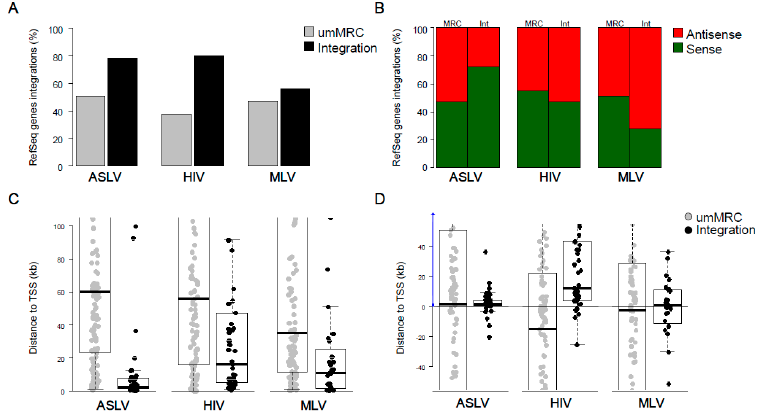
Figure 3. Analysis of genomic features at the integration sites of stable active proviruses. ( A ) Percentage of proviruses identified inside RefSeq Genes. ( B ) Orientation of proviruses inside RefSeq Genes relative to the transcription of targeted genes. ( C ) Distance of proviruses to the nearest TSS of RefSeq Genes (in kb). ( D ) Distribution of proviruses around TSS. The positive values mark the distance downstream from RefSeq Gene TSS. umMRC, uniquely mapped matched random control.